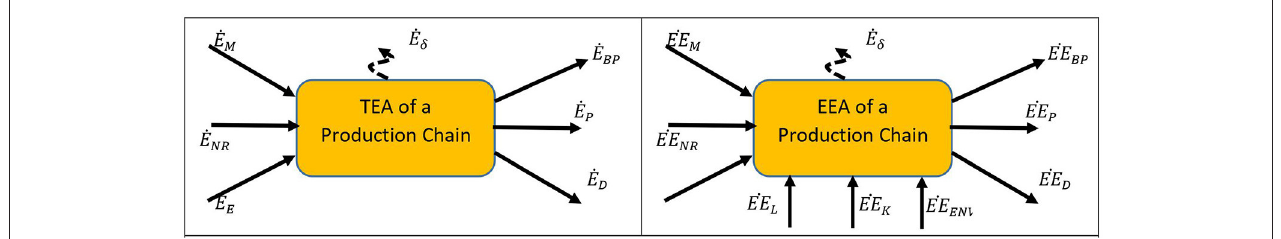
FIGURE 12 | For the comparison of the tec with the eec